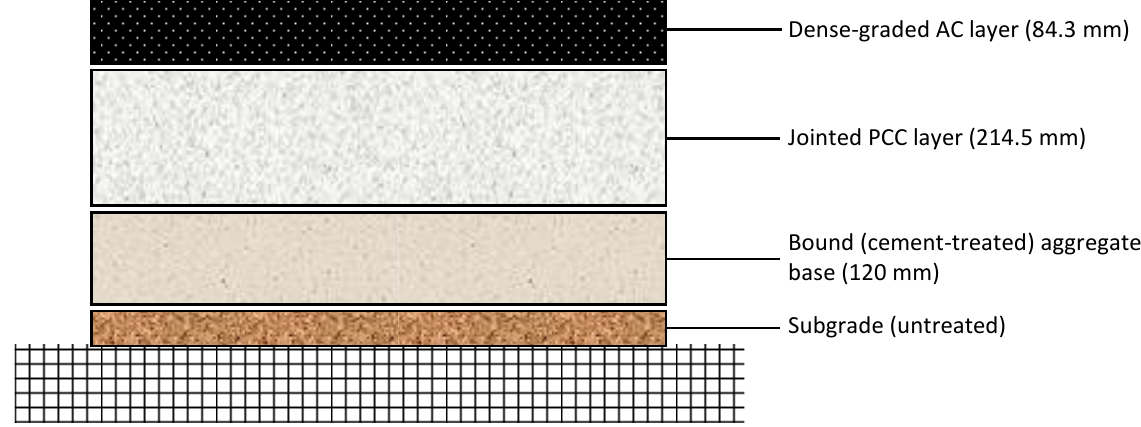
Figure 4. Pavement cross-section of LTPP test section 06-0606 (not in scale; data source: [33]).